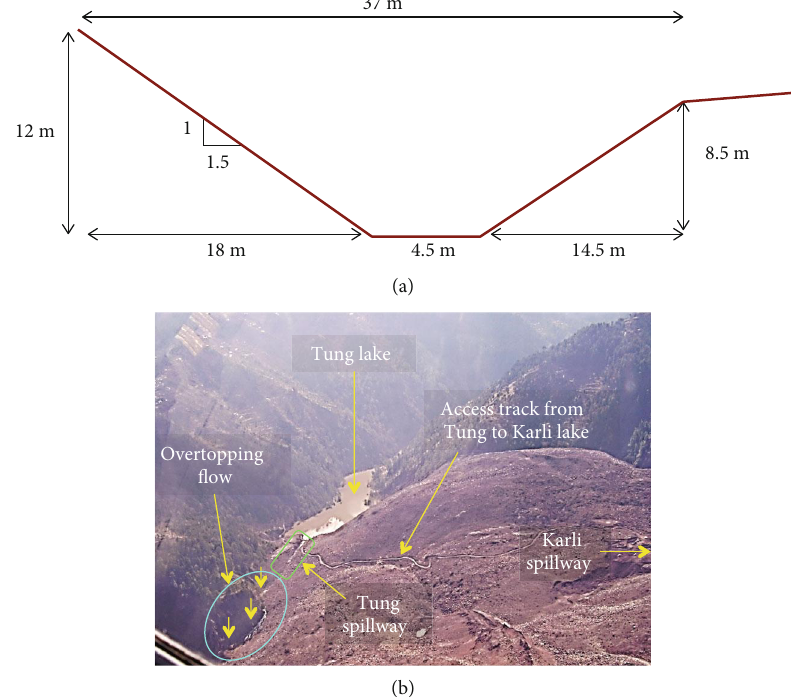
Figure 7: (a) Cross-section of the deepest spillway cut along the landslide dam portion blocking Tung lake; (b) photograph of Tung lake overtopping newly excavated spillway (February 12,